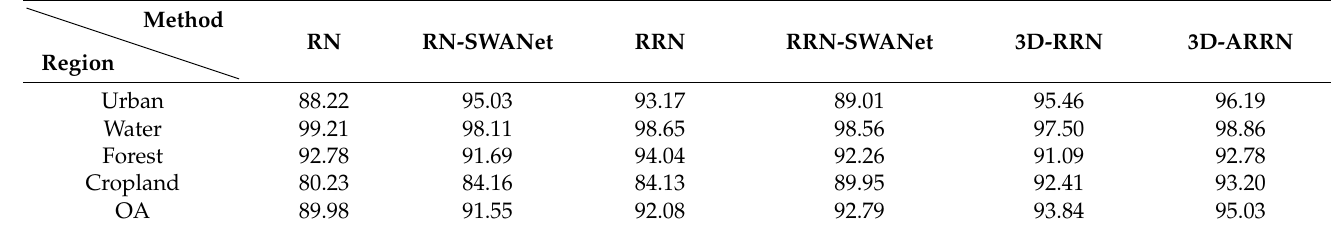
Table 4. The classification accuracy of different methods with 7 labeled samples per class on Flevoland